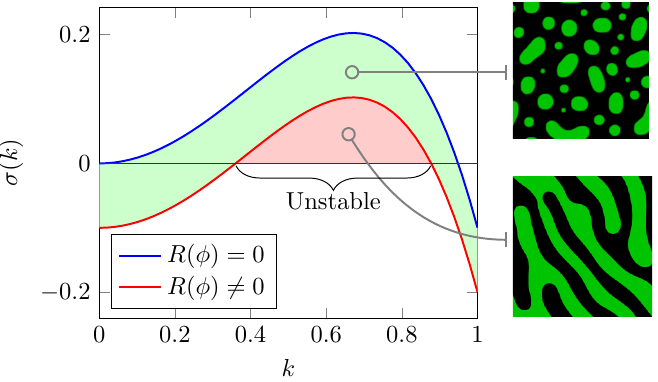
Figure 9. Dispersion characteristics of phase-separated morphologies with and without chemical reactions at late stages of evolution. The inclusion of chemical reactions can result in unstable wave [ 0.37,0.87 ] ) that are independent of domain size. These independent states may lead to vectors ( k ∈ domain-coarsening arrest, resulting in the phase-separated morphologies changing from droplets to striped patterns akin to anomalous gel-like morphologies observed in